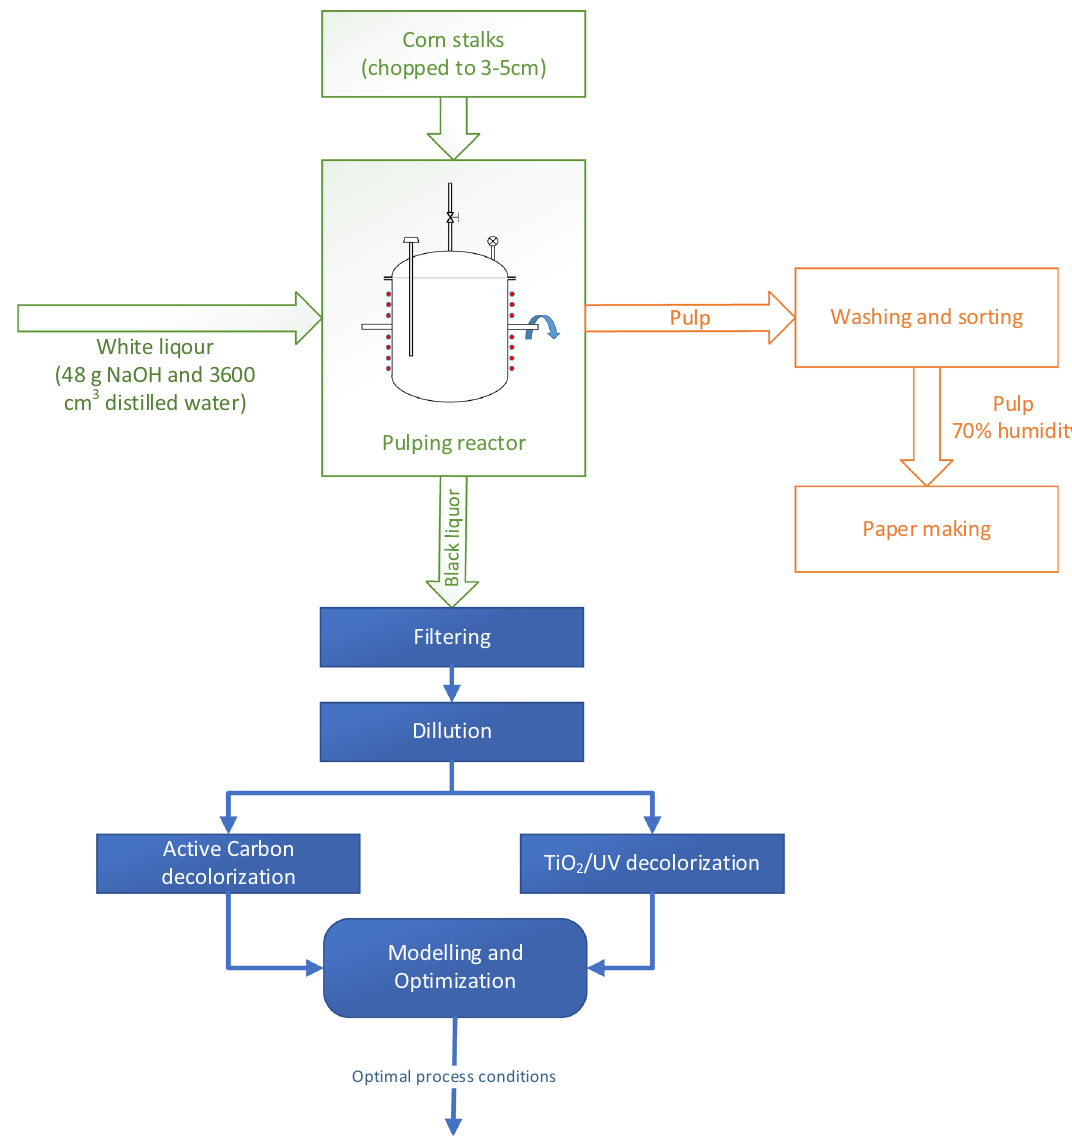
Figure 1. Simplified schema for processing corn stalks and black